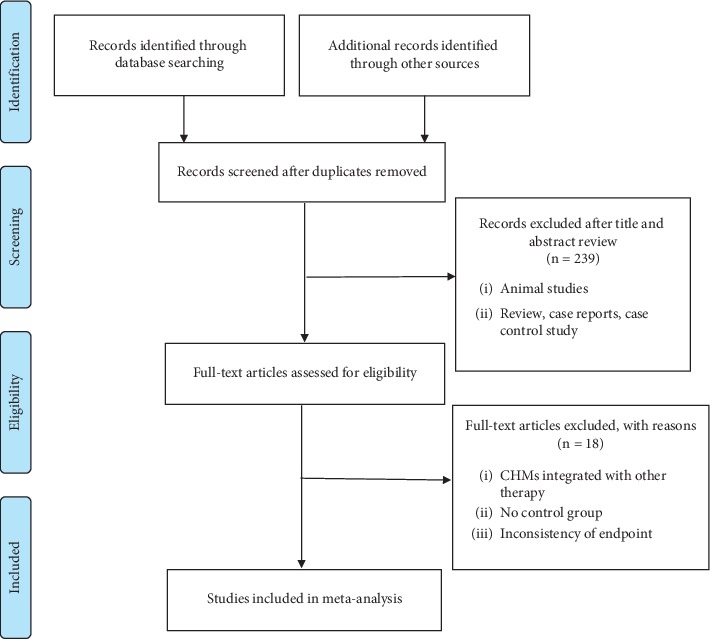
The ﬂowchart of study selection.